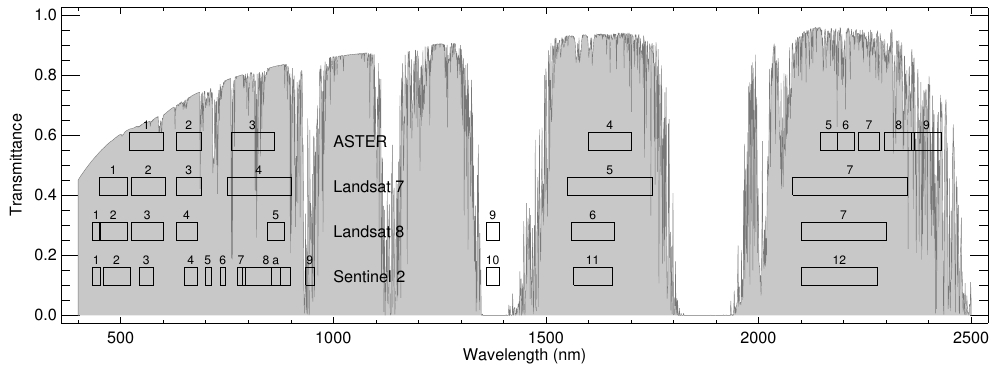
Figure 1. The width, wavelength positions and numbers of the Sentinel-2A MSI (MultiSpectral Instrument) spectral bands, in comparison to Landsat 8 OLI (Operational Land Imager), Landsat 5 TM (Thematic Mapper) and ASTER (Advanced Spaceborne Thermal Emission and Reflectance Radiometer). Atmospheric transmittance is plotted on the y